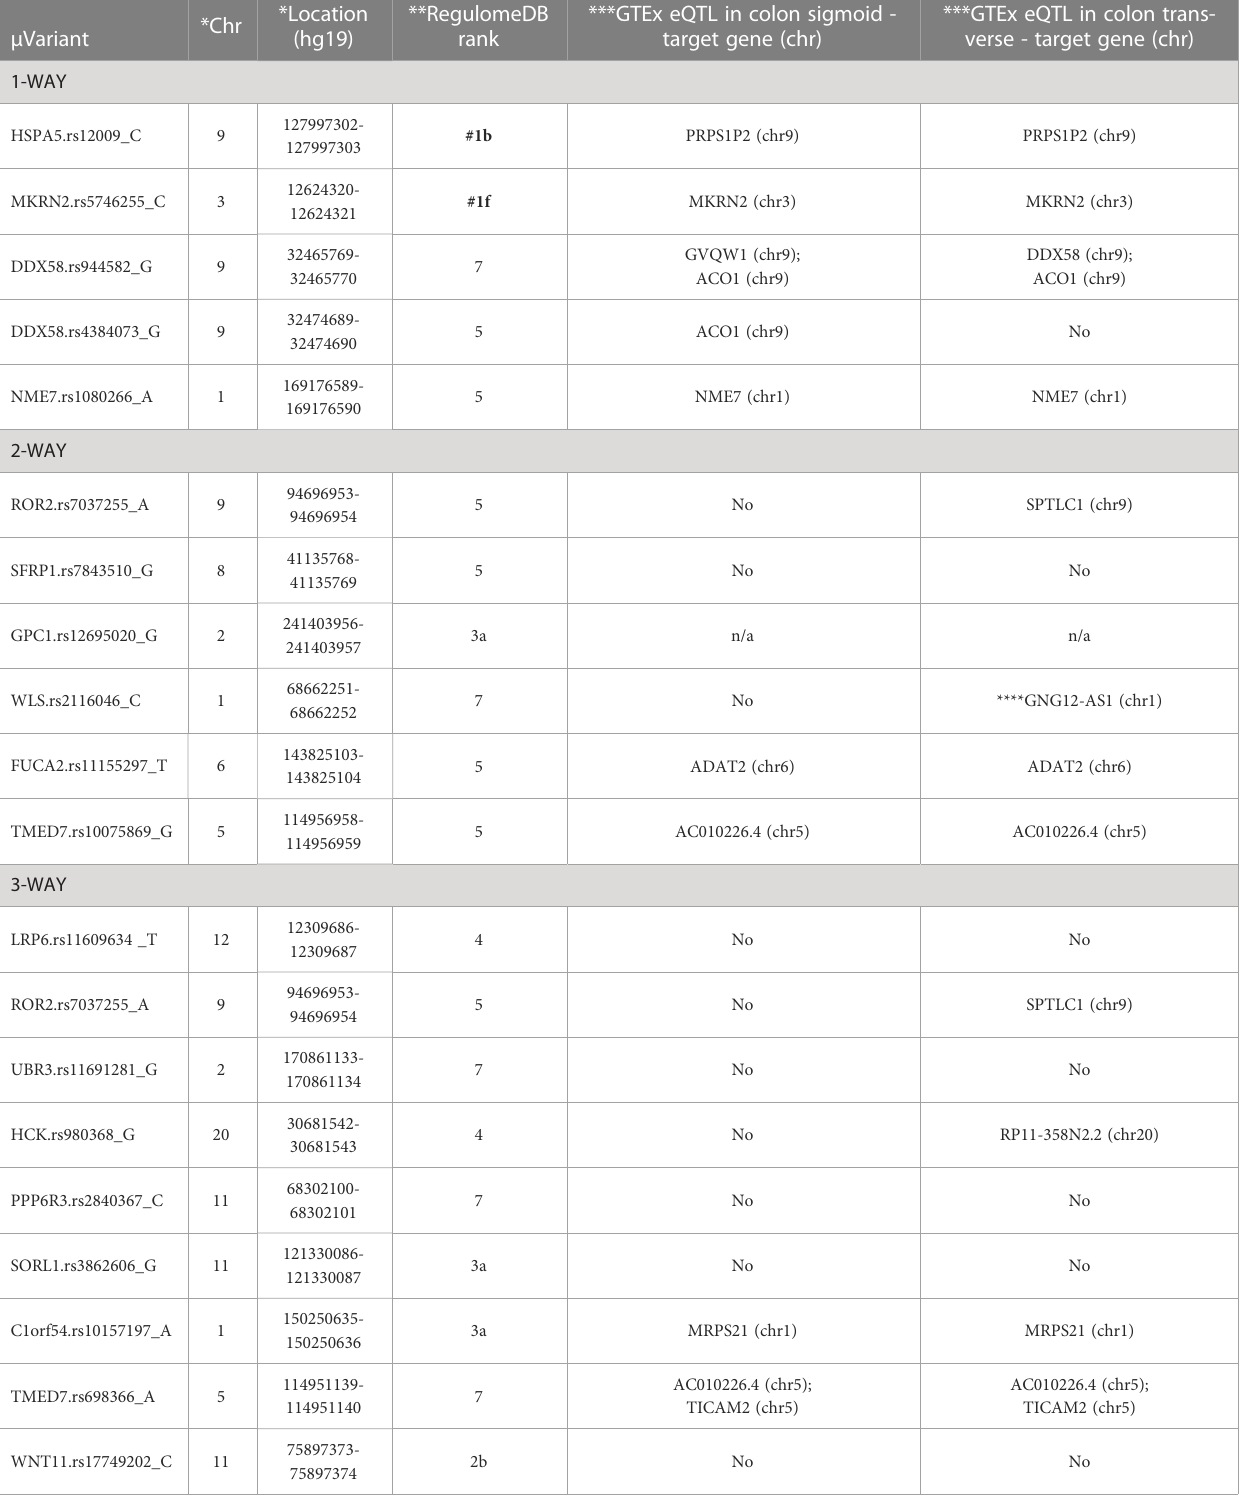
TABLE 3 eQTL information for the SNPs identi fi